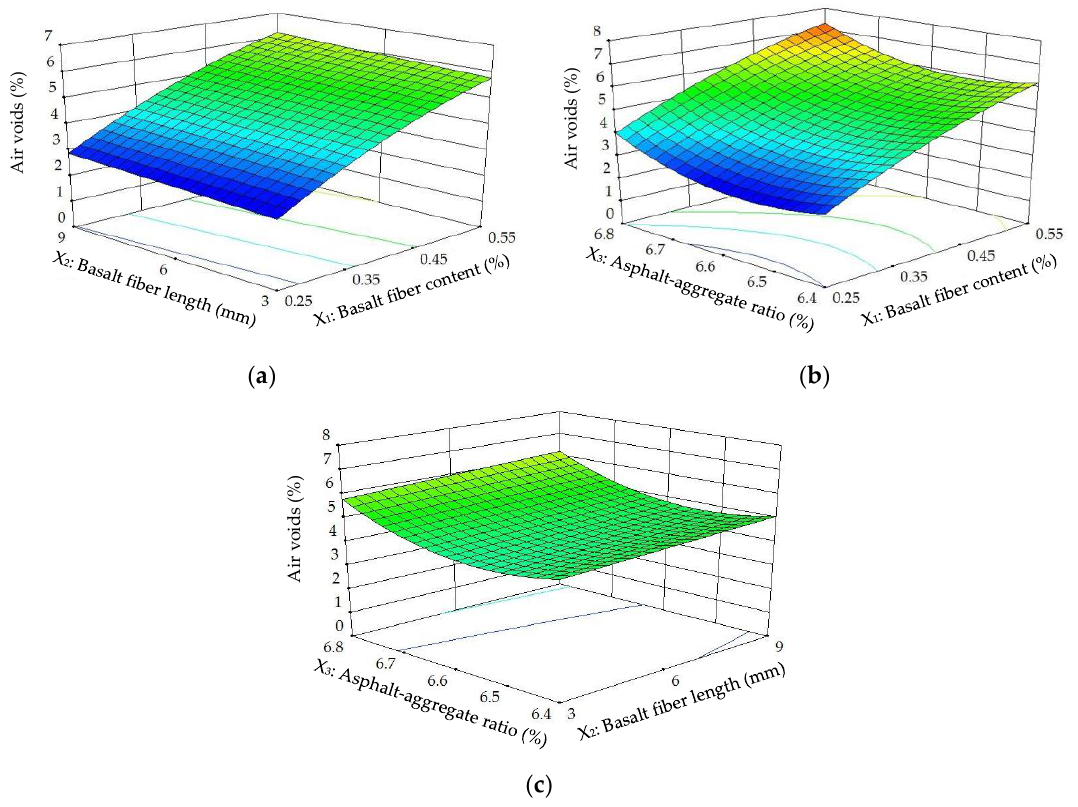
Figure 11. Response surface plots between VA and factors: ( a ) Factors: BFC and BFL at AAR = 6.6%; ( b ) Factors: BFC and AAR at BFL = 6 mm; ( c ) Factors: BFL and AAR at BFC = 0.4%.